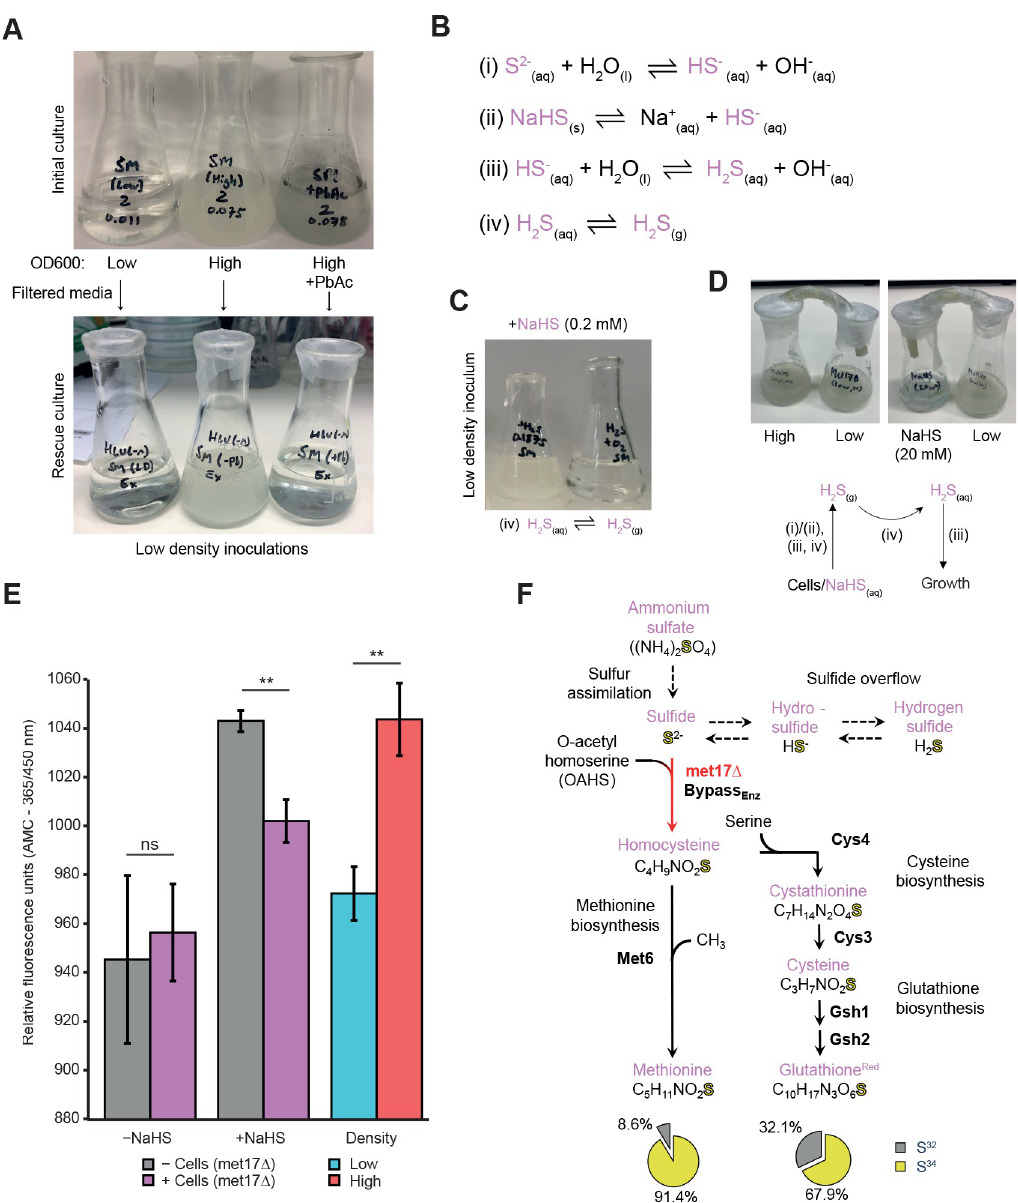
Fig 2. Hydrogen sulfide is essential for the rescue of organosulfur auxotrophy of met17 Δ . (A) met17 Δ cultures inoculated at low starting density (OD 600nm < 0.01) and high densities (OD 600nm � 0.02) (upper panel, left and middle). One flask of high- density inoculation was supplemented with Pb(II) acetate to precipitate H 2 S, forming lead sulfide (upper panel, right). Conditioned media from these three cultures was subsequently filtered, replenished with YNB and glucose, and reinoculated at low density (lower panel). Data are representative from two biologically independent experiments. (B) Reaction schemes. Hydrolysis of sulfide is in equilibrium with hydrosulfide and hydrogen sulfide (i, iii, iv). NaHS can serve as a hydrosulfide donor (ii) in solution. Hydrogen sulfide preferentially undergoes phase transition to a gaseous state (iv) in unsealed vessels or establishes a dynamic equilibrium with its aqueous counterpart in sealed vessels. (C) Growth of met17 Δ cultures supplemented with NaHS and inoculated at low density, sealed vs. unsealed. (D) Cultures inoculated with the met17 Δ strain where the vessels are connected via rubber tubing to facilitate gaseous exchange, either between a high-density culture or a high-concentration solution of NaHS (20 mM). Schematic indicates the reactions occurring at each stage to facilitate the growth of low-density cultures. (E) Quantification of hydrogen sulfide production and uptake via conversion of AzMC to AMC [21] between unsupplemented and NaHS supplemented cultures inoculated at low density in the presence (purple) or absence (gray) of met17 Δ cells. Blue and red bars indicate a separate experiment where hydrogen sulfide production was quantified met17 Δ cultures inoculated at either low (blue) or high (red) density, in a similar experiment as shown in (A). P values calculated via two-tailed Student t test, where n = 3 independent replicates. (F) Isotopic tracing experiment with pathway map indicating